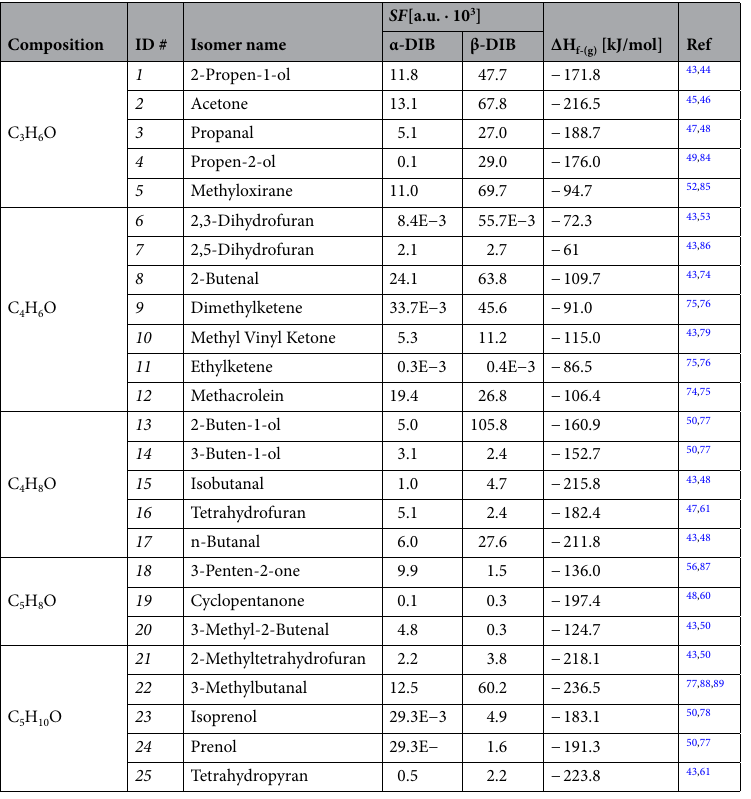
shown in Eq. (1), where the subscript- i denotes the sample species and subscript- R denotes the reference species. In Eq. (1), the signal, S , is a function of the species partial pressure, P , the wavelength-specific photoionization cross section σ ( E ) and the mass dependent response factor, R , which depends on the instrumentation in use. In this work, it is assumed that values of R are unity.